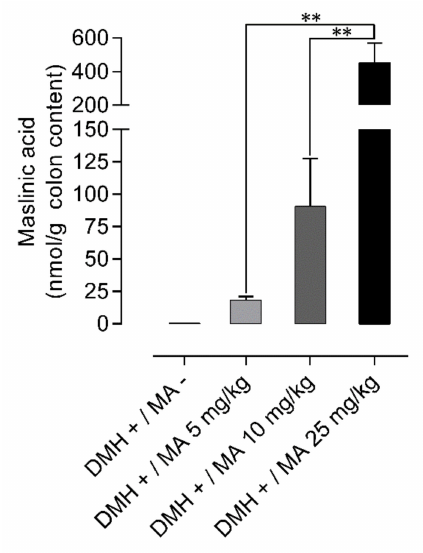
Figure 7. Concentrations of maslinic acid in the colon content of DMH-injected rats obtained 24 h after the last oral administration of the pentacyclic triterpene at the doses of 0, 5, 10 and 25 mg/kg after 49 days of treatment. Results are expressed as mean + SEM and were evaluated with one-way ANOVA and Bonferroni’s multiple comparisons test, n = 6–8. Asterisks indicate differences between doses: ** p <